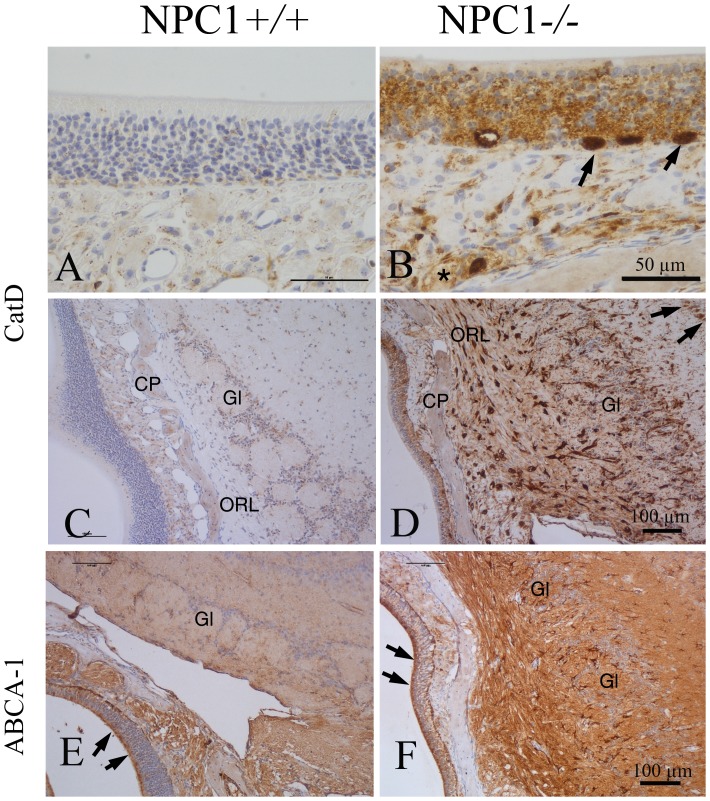
CatD (A–D) and ABCA-1 (E–H) immunoreactivity.(A) Normal distribution of CatD reactivity in NPC1+/+; typical dot-like residues in cells of the lamina propria and basal cells of the olfactory epithelium. (B) Dramatically increased CatD reactivity is detected in all epithelial cells in NPC1−/−, especially suprabasal cells, most probably macrophages as demonstrated in Figs. 4C and 8. Also enhanced reactivity also of ensheathing cells of ORN bundles in the lamina propria (asterisk). (C) Overview of the interface between OE and OB in NPC1+/+ mice. (D) CatD reactivity is dramatically increased in all layers of the OB, including mitral cells (small arrows, upper right corner) and periglomerular cells in NPC1−/−. Gl, glomerular layer, CP, cribriform plate. (E, F) Reactivity of ABCA-1 is increased in nerve fibers of NPC1−/− animals (F), whereas supporting cells (arrows) of the OE displays similar intensities in both wild type (E) and mutant (F) animals.